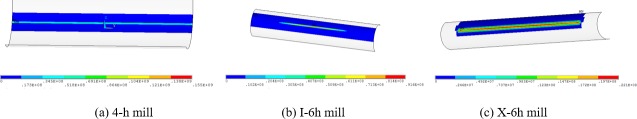
Contact stress field of the different roll layouts.